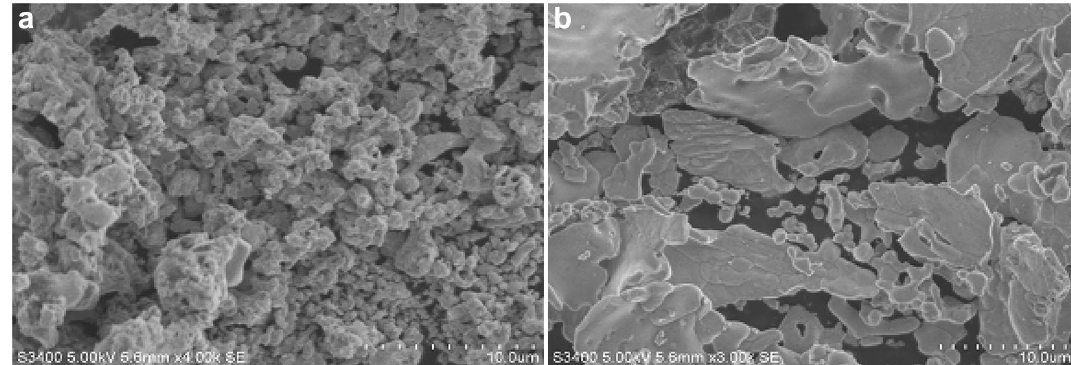
Figure 4. SEM of bare CPE ( a ) and PoOCD/MCPE ( b ).